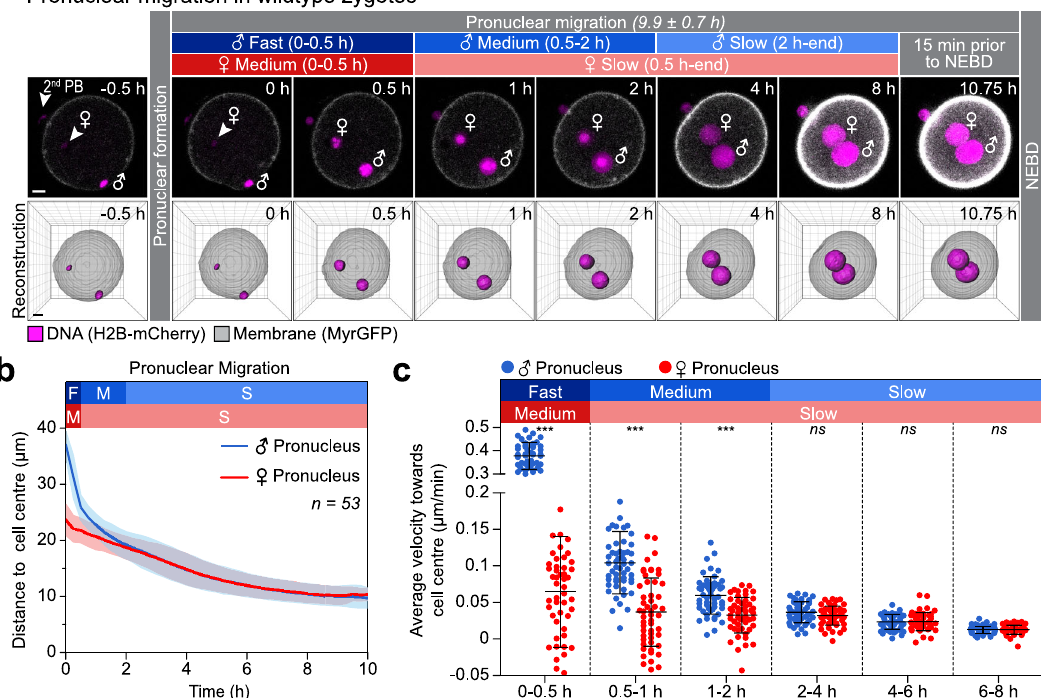
Fig. 1 Pronuclei migrate by different modes in the periphery and central region of the zygote. a Three-dimensional time-lapse images (upper panel) and iso-surface reconstruction (lower panel) of pronuclei (H2B-mCherry, z-projection of 28 sections, every 3 µ m) and the cell surface (MyrGFP, equatorial section) in live zygotes relative to pronuclear formation (0 h). Female ( ♀ ) and male ( ♂ ) genomes are labelled; as well as the second polar body (PB), which forms around excess maternal DNA in meiosis II. Distinct phases of migration for male and female pronuclei were de fi ned according to migratory behaviour of male (blue) or female (red) pronuclei (for details see text), which were further characterized by typical speeds within certain ranges as follows: fast (>0.1 µ m/min), medium (0.05 – 0.1 µ m/min) and slow (<0.05 µ m). Duration of pronuclear migration from pronuclear formation to nuclear envelope breakdown (NEBD) was quanti fi ed in Supplementary Fig. 1m. Scale bar, 10 μ m. b The mean distance (thick line) of male ( ♂ , blue) and female ( ♀ , red) pronuclei centroids to zygote centre during pronuclear migration was calculated from data sets as shown in ( a ). Movement speeds are classi fi ed as in ( a ). Total number of analyzed zygotes speci fi ed in italics was pooled from fi ve independent experiments. S.d. shown as shaded areas. c Statistical plots of average velocities of male ( ♂ , blue) and female ( ♀ , red) pronuclei during pronuclear migration calculated from data sets shown in ( b ) with the sample size as in ( b ). Statistical plots show mean (horizontal middle lines), and standard deviation (whiskers). Two-tailed Student ’ s t test was used to test for signi fi cance (from left to right: p < 0.0001, p < 0.0001, p < 0.0001, p = 0.09, p = 0.9 and p =